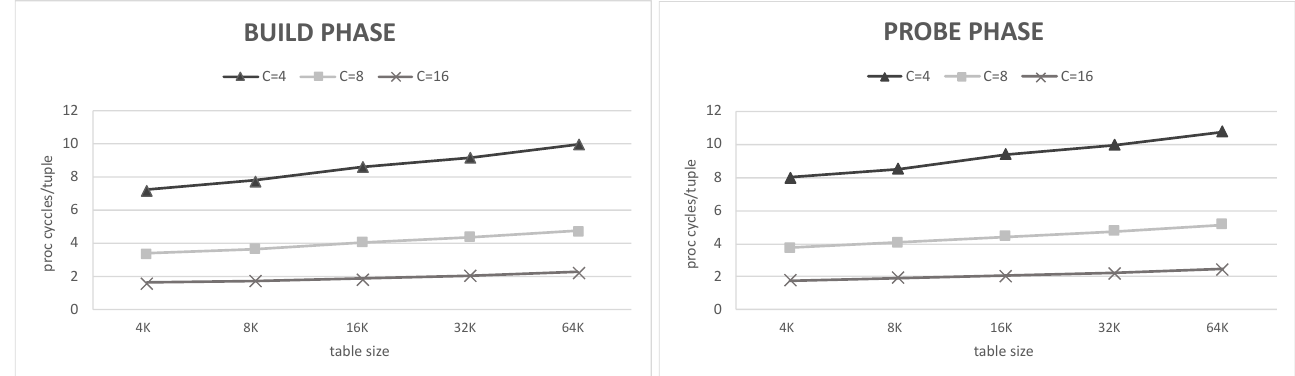
BUILD PHASE PROBE PHASE